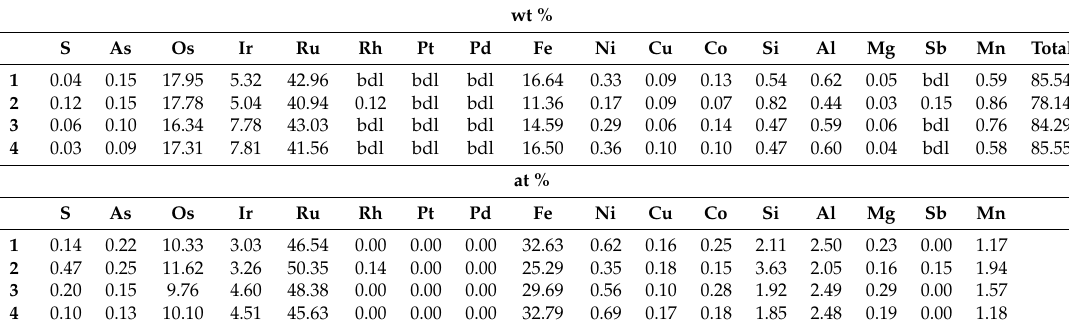
Table 3. Composition of the fibrous PGM analyzed by electron microprobe (EMP).